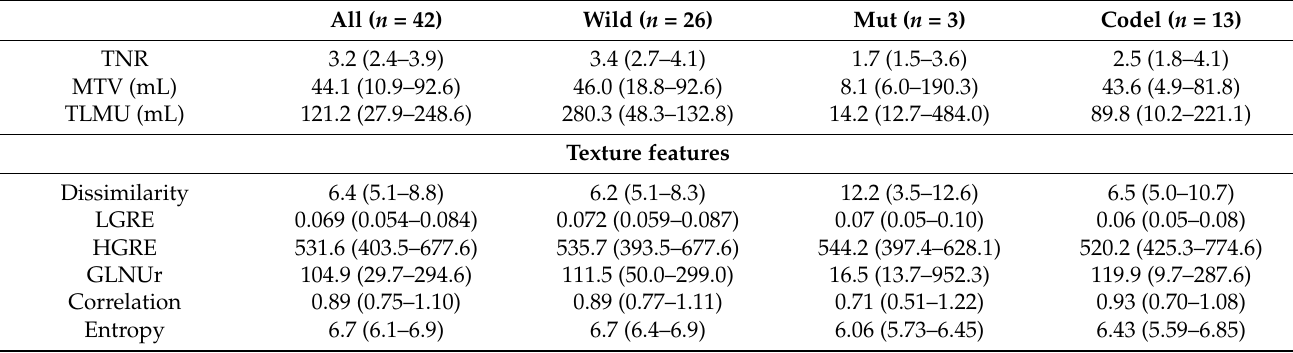
Table 2. The MET PET